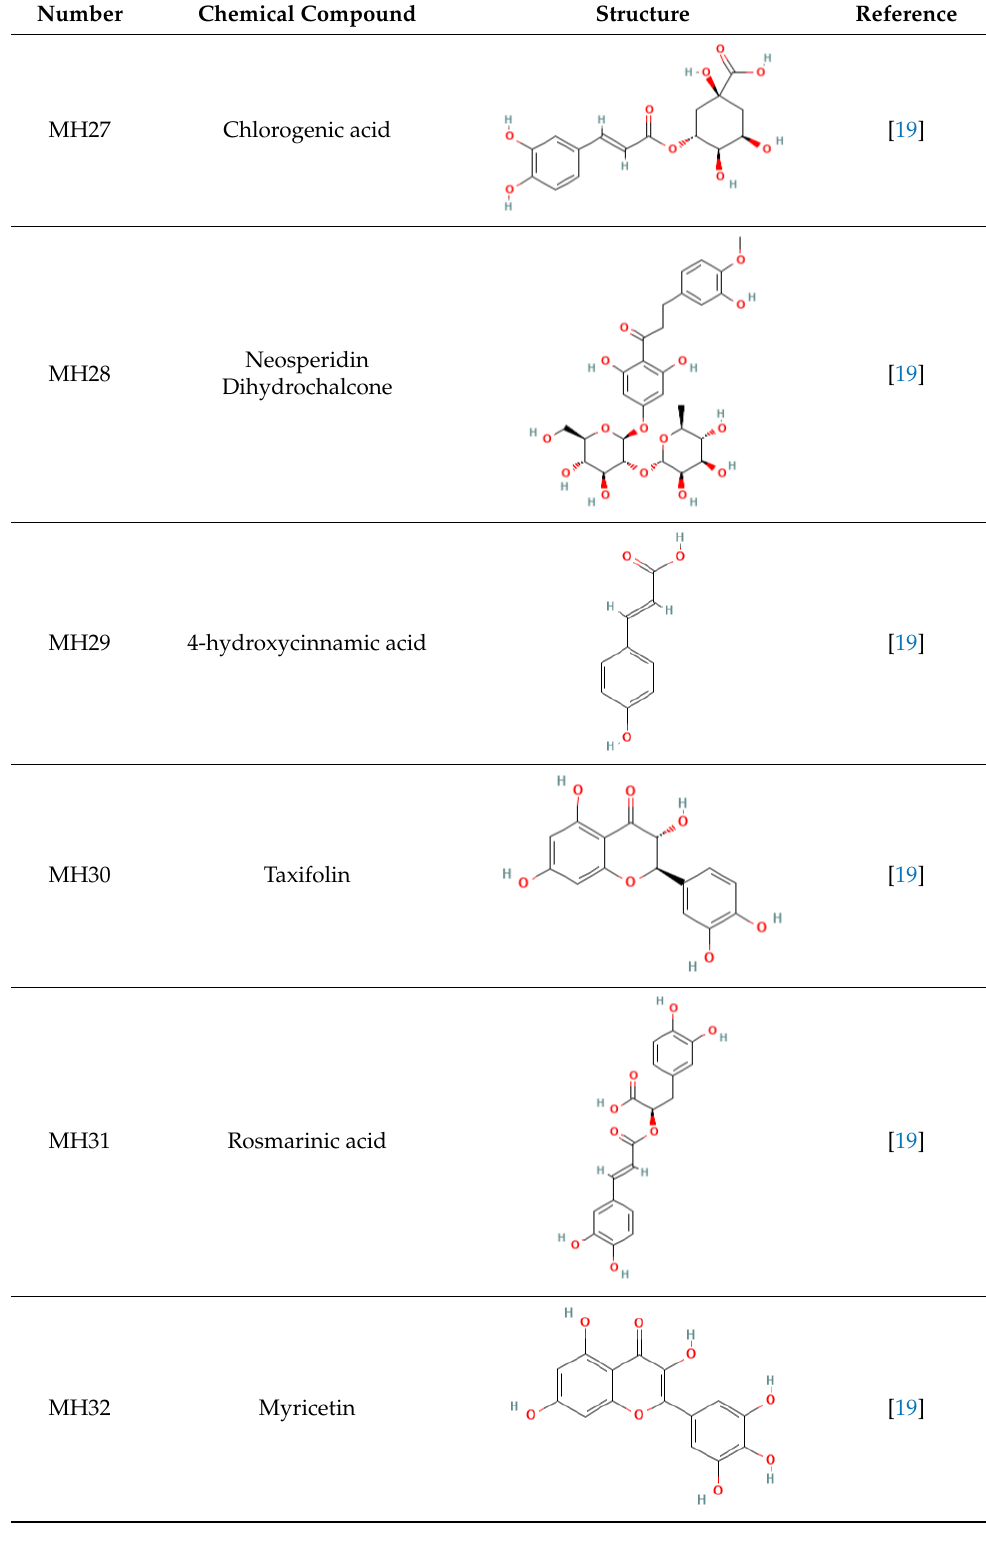
Table 1. Cont. Number Chemical Compound